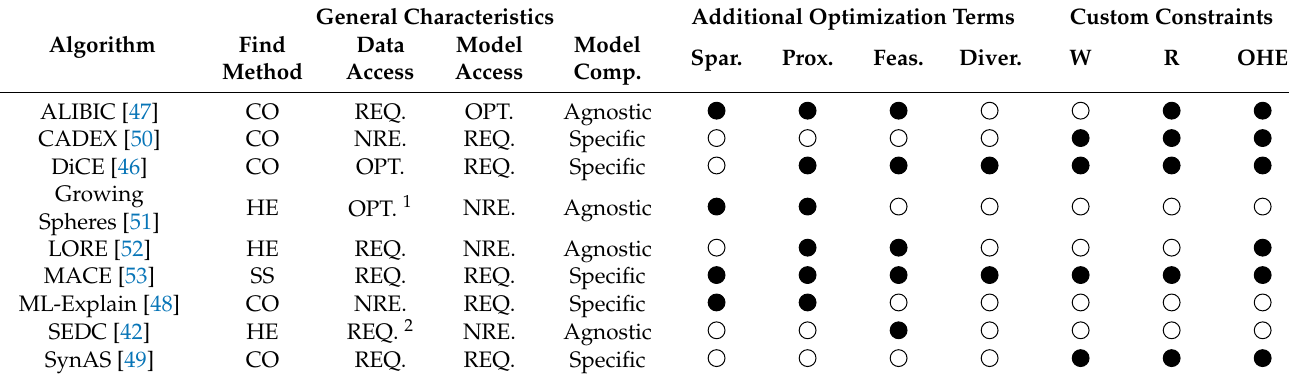
Table 1. Overall counterfactual explanation generation algorithm characteristics. Black filled circles indicate the feature is present, while white filled circles represent that the feature is not present. CO : Convex Optimization. HE : Heuristic. SS : Satisfiability Solver. REQ. : Required. NRE. : Not Required. OPT : Optional. Spar. : Sparsity. Prox. : Proximity. Feas. :